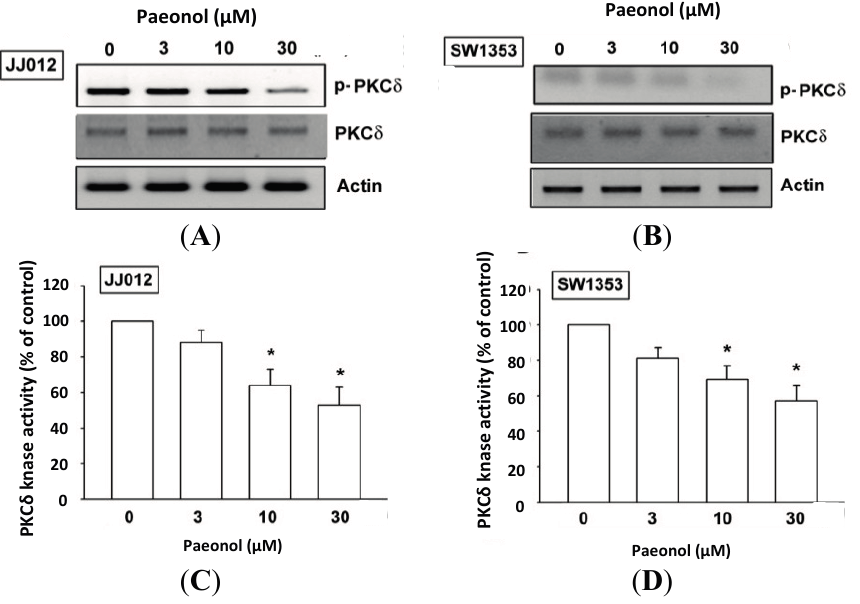
Figure 4. Protein kinase C (PKC)  involved in paeonol response of human chondrosarcoma. Cells were incubated with various concentrations of paeonol for 24 h; PKC  phosphorylation and kinase activity was examined by western blot ( n = 4) and PKC  kinase activity kit ( n = 6). Results are expressed as mean ± S.E.M. * , p < 0.05 compared with control.